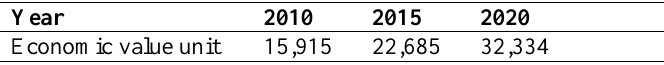
Table 3. The forecasting data of an economic value